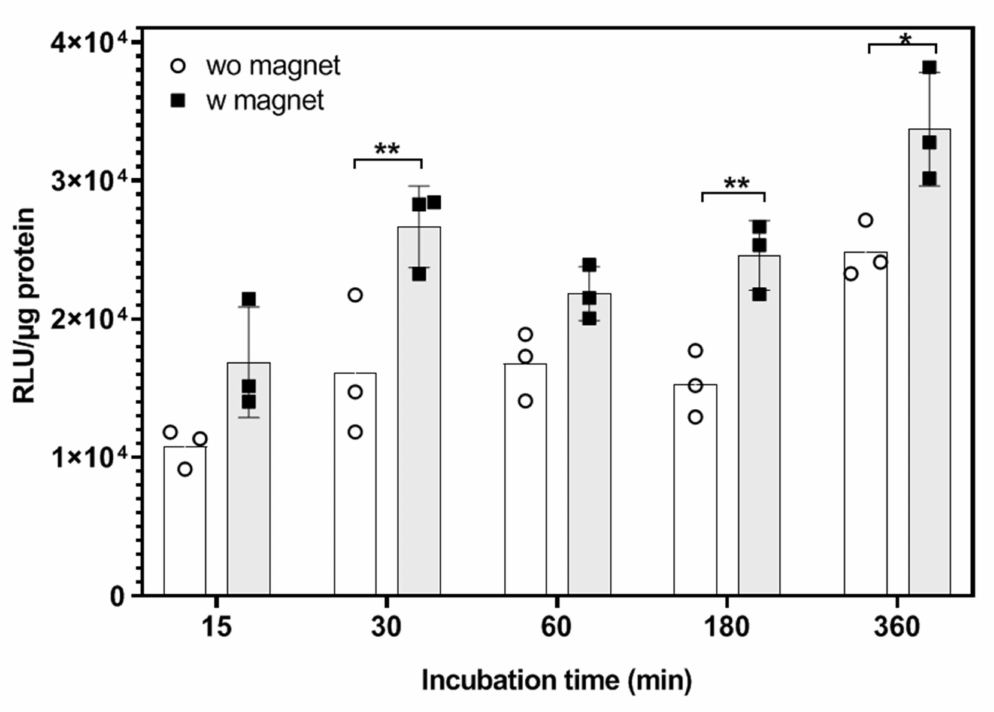
Figure 17. E ff ect of magnetic field exposure on the transfection e ffi ciency of lipoplexes (cosol_MCLs / pFAR4-luc, RC8) in a CT26 cell line for di ff erent incubation times. Cells were seeded at 10 4 cells / well in a 96-well plate. Luciferase and protein assay were carried out 24 h after the incubation of cells with 100 µ L of lipoplexes containing 1 µ g of pFAR4-luc in the absence (clear circle) or presence (dark circle) of a magnetic field for various incubation times. The transfection e ffi ciency is calculated as RLU / ug protein. The data given are averages of triplicates of one experiment ( n = 3); bars, SD. Two-way ANOVA was done with GraphPad Prism software, * p ≤ 0.05, ** p ≤ 0.01. RLU, relative light unit; RC = nmol DMAPAP / µ g